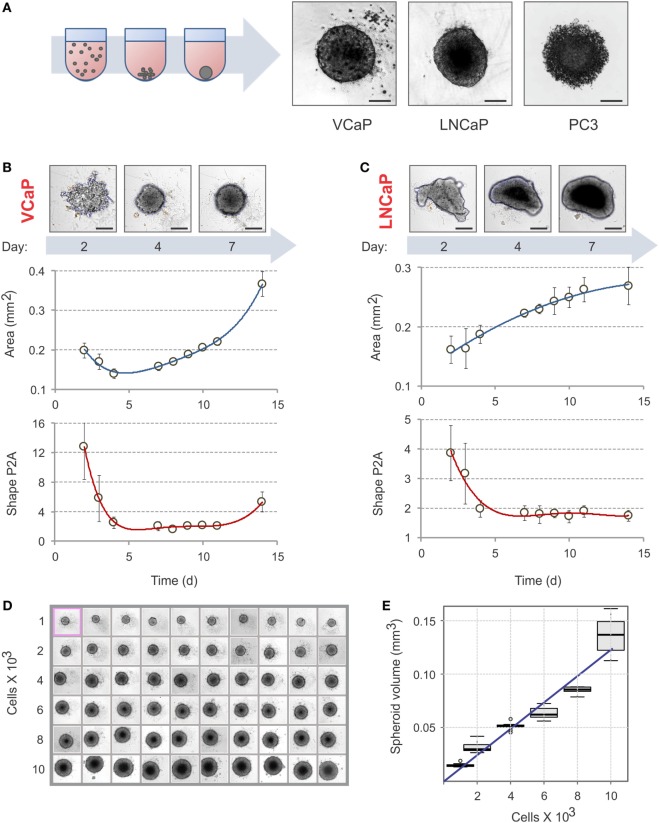
Spheroid assembly in U-bottom, 96-well NTA plates. (A) Schematic diagram of spheroid assembly. Representative images on the right show the aggregates formed by VCaP (4,000 cells seeded), LNCaP (1,000 cells seeded), and PC3 (500 cells seeded) cells in 7 days. The images were acquired with a Zeiss Observer Z1 microscope. Scale bar, 200 µm. For real-time observation of VCaP spheroid assembly, see Movie S1 in Supplementary Material. (B,C) Kinetics of spheroid assembly. Spheroids were formed with (B) 2,000 VCaP cells and (C) 500 LNCaP cells. The images were acquired with a CellInsight NXT HCS platform, and the aggregate “Area” and “Shape P2A” (roundness) metrics were calculated using a Morphology.V4 application. Scale bar, 200 µm. The plots show the data analyzed with “R” statistics software (mean ± SD, 24 spheroids per cell line). (D) Uniformity of VCaP spheroid assembly. Representative CellInsight images of spheroids formed by varying numbers of VCaP cells over 7 days. The field of view is 896.6 µm × 896.6 µm. (E) The box plots show the corresponding VCaP spheroid volumes estimated with Morphology.V4 and analyzed with R software. The slope of the linear trend line corresponds to ~12 pL of occupied volume per seeded cell.